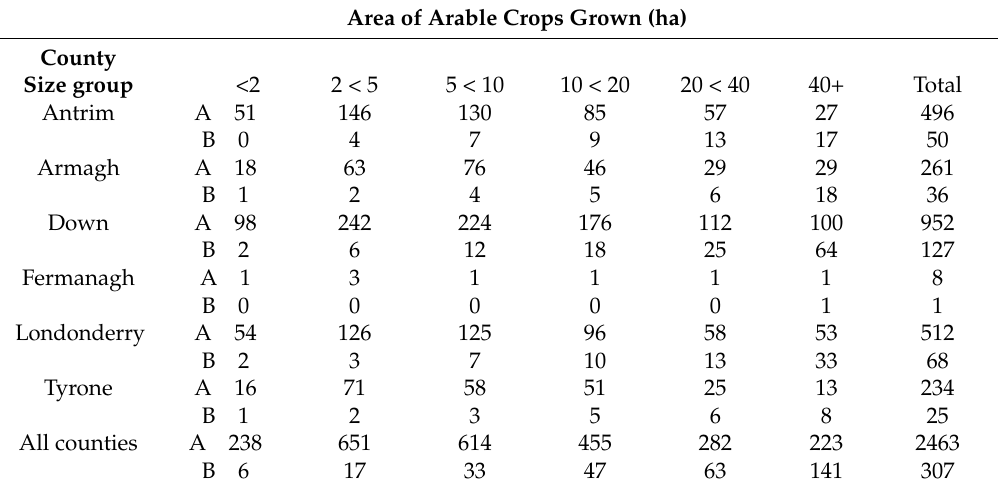
Table 1. A typical sampling frame for monitoring pesticide use in arable crops in Northern Ireland. Area of Arable Crops Grown (ha)